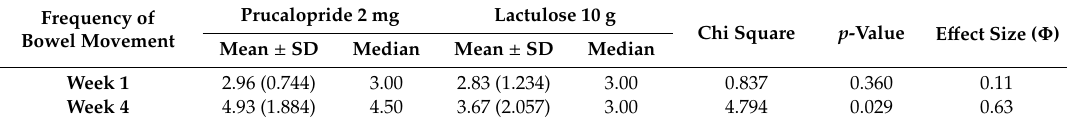
Figure 1. Disposition of patients in the open label, head to head comparison study between Prucalopride and Lactulose for Clozapine induced constipation in patients with treatment resistant schizophrenia.